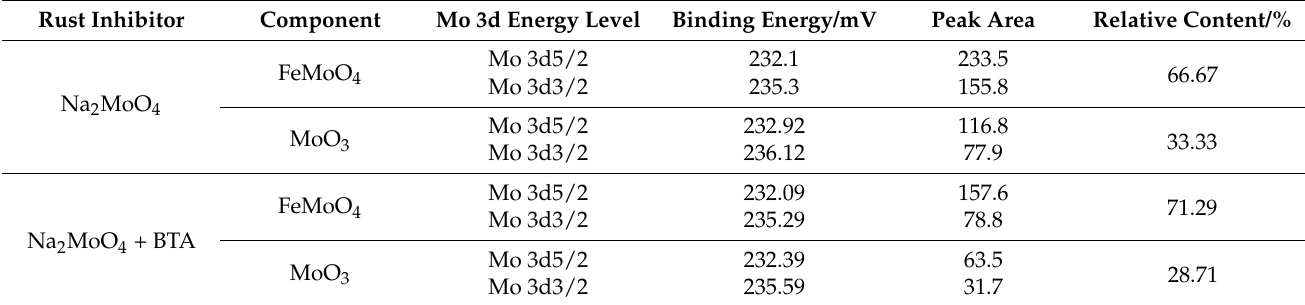
Table 7. Fitting data of the Mo element in different groups.